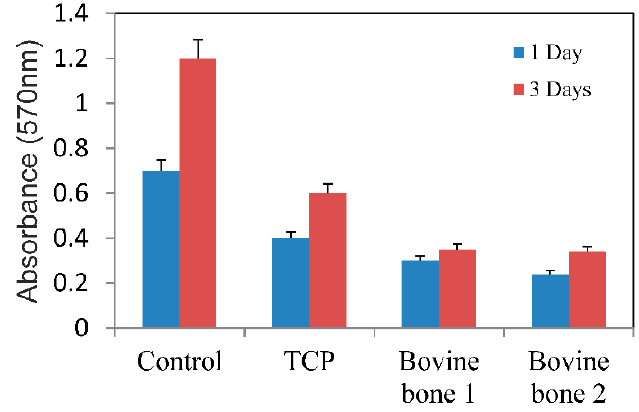
Figure 9. Viability assay of the cells growing in both test materials (bovine bone 1 and 2), TCP, and control plate assessed by the MTT bioassay. The mean values of absorbance at 570 nm are represented. The mean values are expressed as a percentage ± standard deviation.